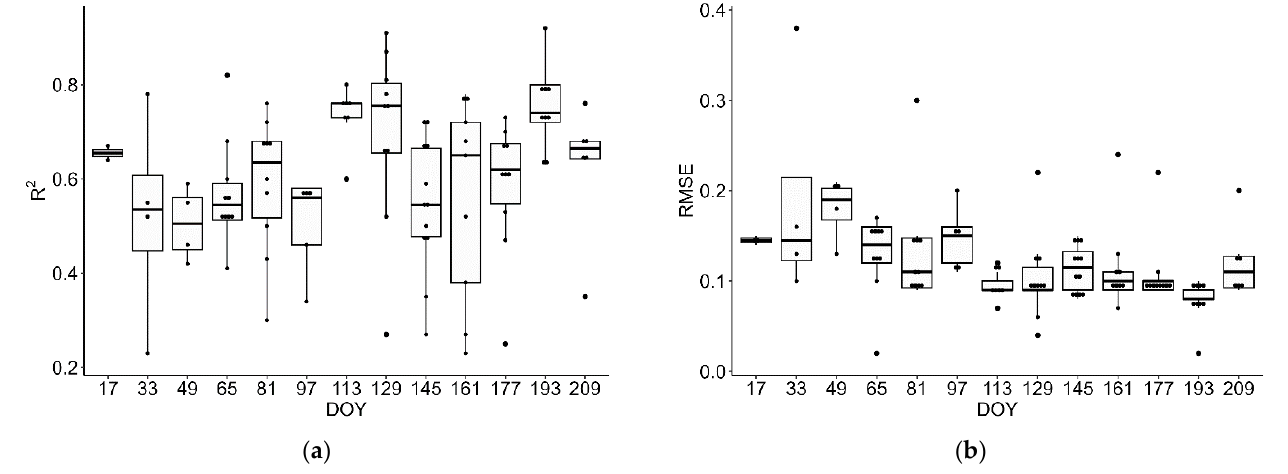
Figure 5. The day of the year (DOY)-based comparison of correlation coefficients between ( a ) R 2 values and ( b ) RMSE values obtained during the accuracy assessment of referenced and synthetic NDVI products from 2001 to 2019. The correlation coefficient refers to R (see Equation (5)).